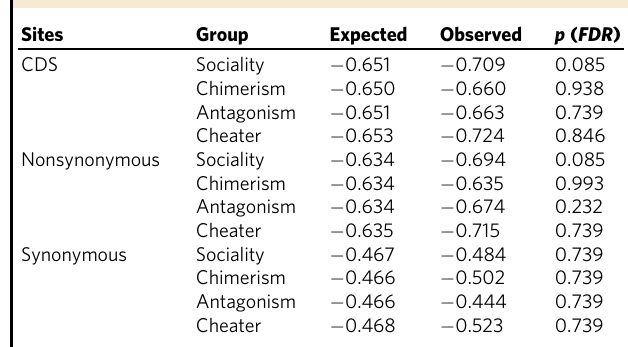
Table 2 Tajima ’ s D for social genes. Expected values and the respective two-tailed p values were obtained by a